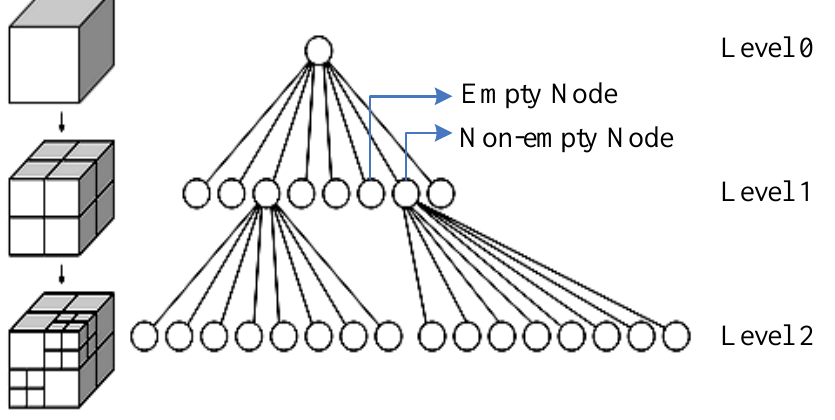
Figure 1. Schematic diagram of the octree structure.